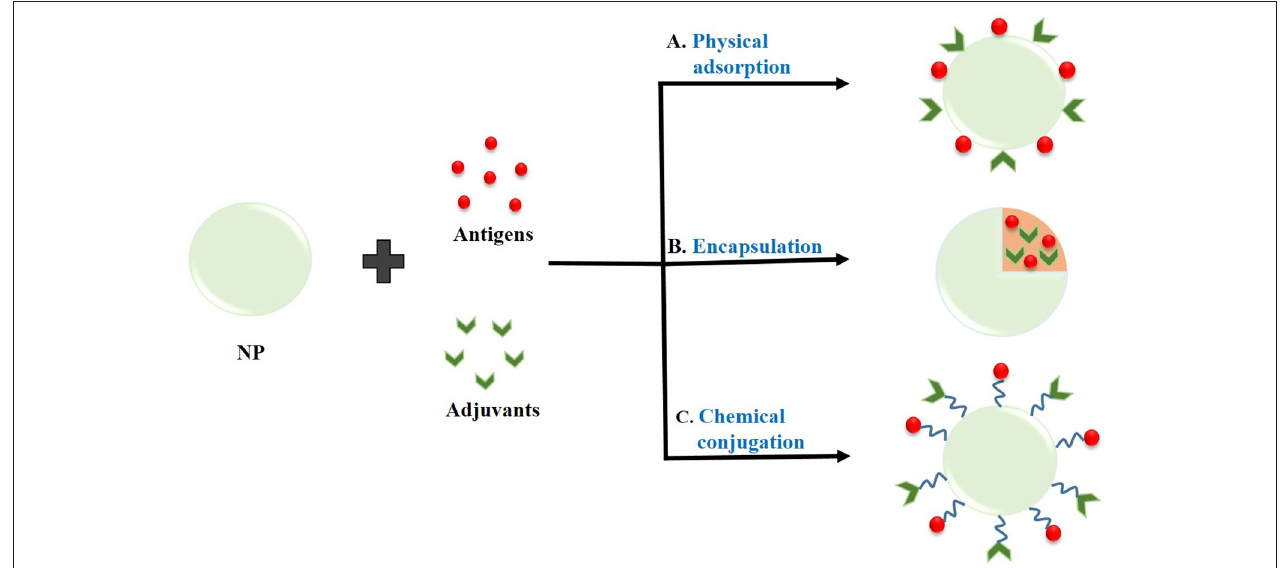
FIGURE 2 | Interaction of nanoparticles (NPs) with antigens or adjuvants by (A) Physical adsorption, (B) Encapsulation, and (C) Chemical conjugation.